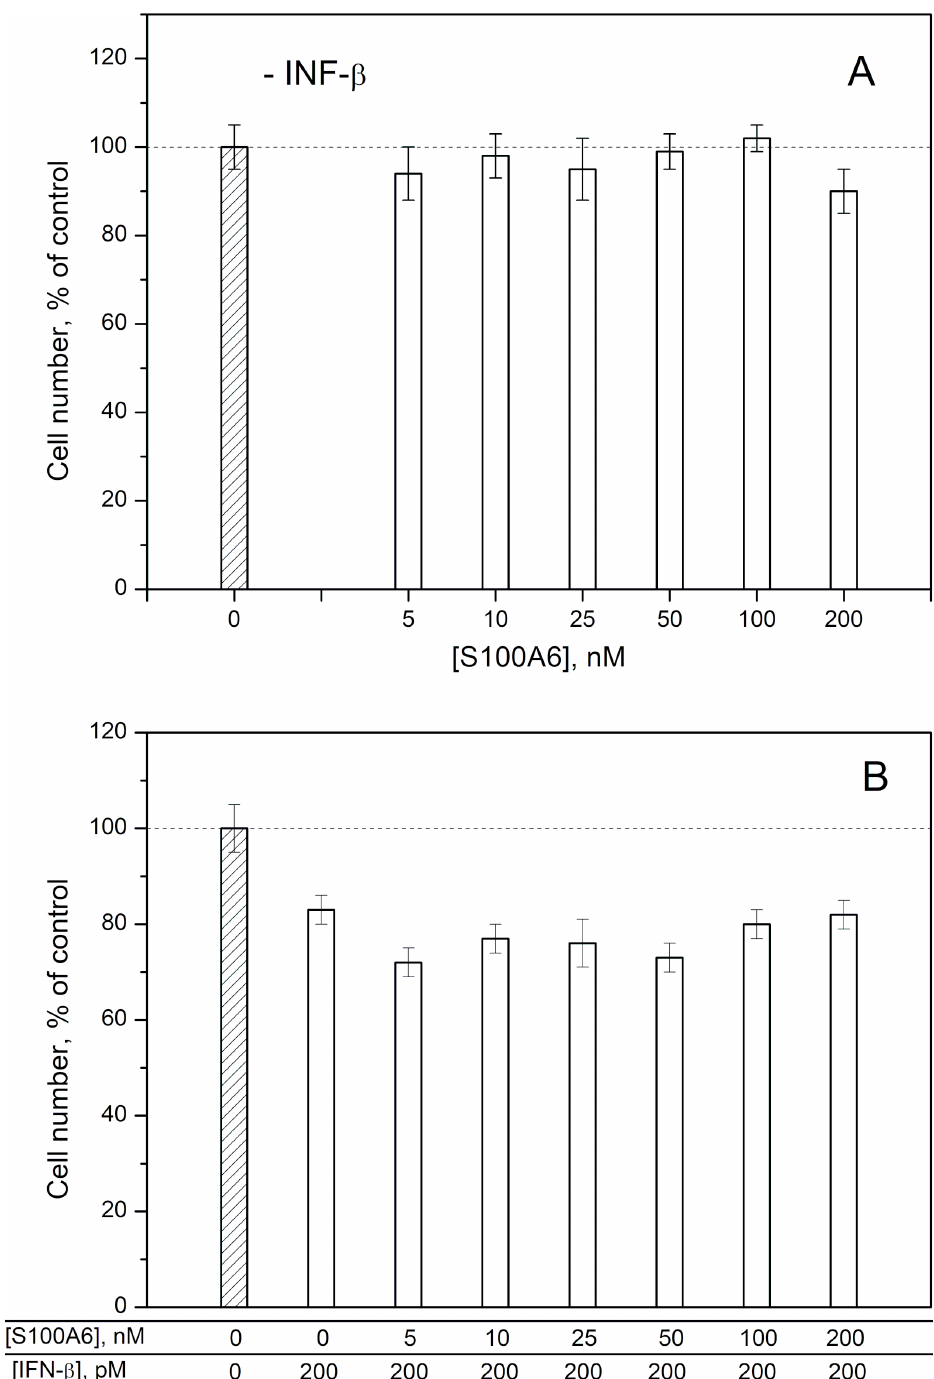
Figure 6. Viability of MCF-7 cells treated by S100A6 protein (panel A ), IFN- β or their combination ( B ) measured by crystal violet assay.